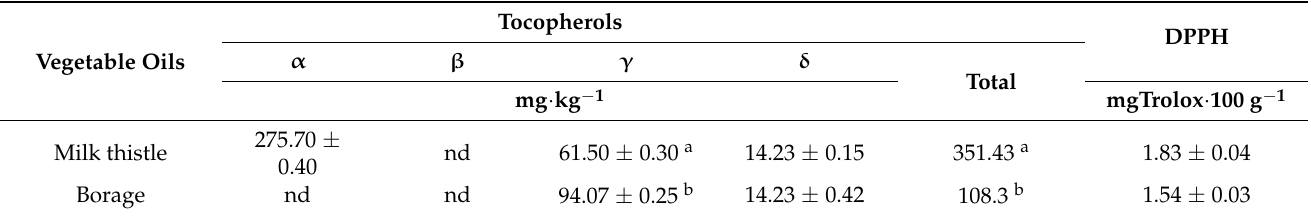
Table 5. Phytochemical compounds with antioxidant effects in oils.